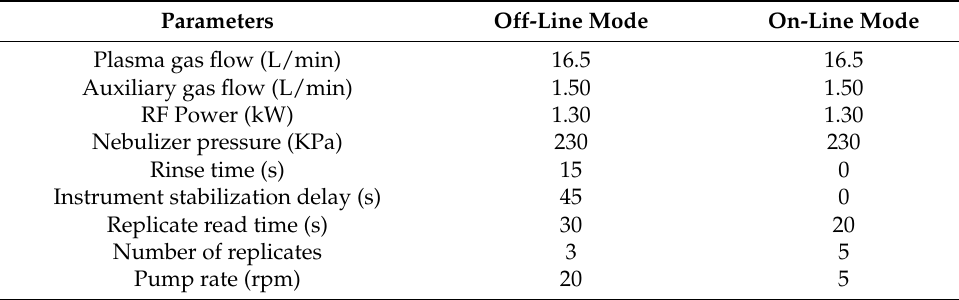
Table 1. ICP-OES reading